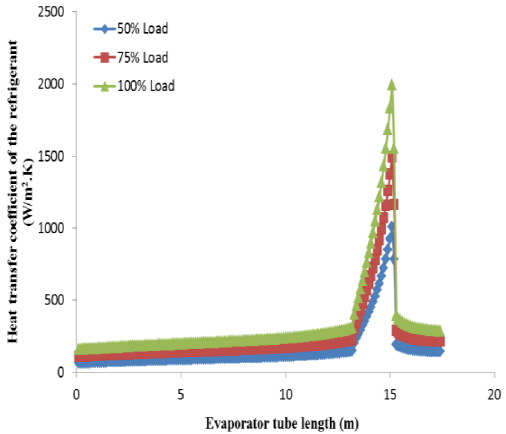
Fig. 6. Heat transfer coef fi cient of refrigerant.